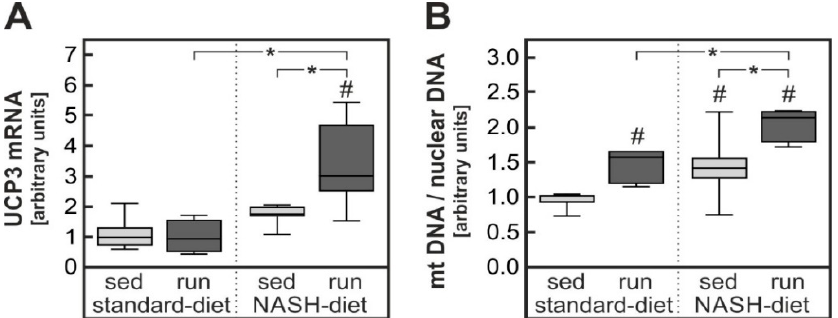
Figure 7 . Diet- and exercise-dependent induction of UCP3 and mitochondrial DNA in skeletal muscle. mRNA, genomic DNA and mitochondrial DNA was extracted from soleus muscle of animals of the different intervention groups described in the legend to Figure 1. ( A ) mRNA of uncoupling protein 3 (UCP3) was quantified by RT-qPCR. ( B ) The copy number of a gene coded by mitochondrial DNA (NADH Dehydrogenase subunit 1) was compared to the copy number of a nuclear-coded gene ( β -actin). Values are median (line), upper and lower quartile (box) and extremes (whiskers). Statistics: Two-way-ANOVA with Tukey’s post hoc test for multiple comparisons; #: significant versus sedentary standard-diet group, * p < 0.05 between compared groups.